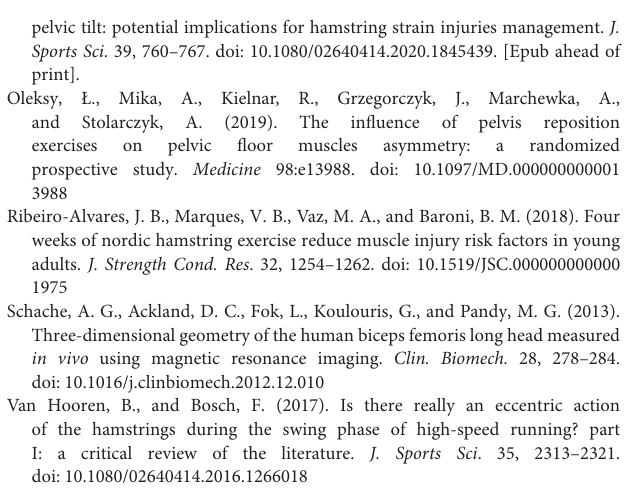
Supplementary Video 1 | Strain forces acting on the biceps femoris muscle long and short heads during movement with lumbo-pelvic complex rotation in relation to body axis 0.1 radian. Supplementary Video 2 | Strain forces acting on the biceps femoris muscle long and short heads during movement with lumbo-pelvic complex rotation in relation to body axis 0.4